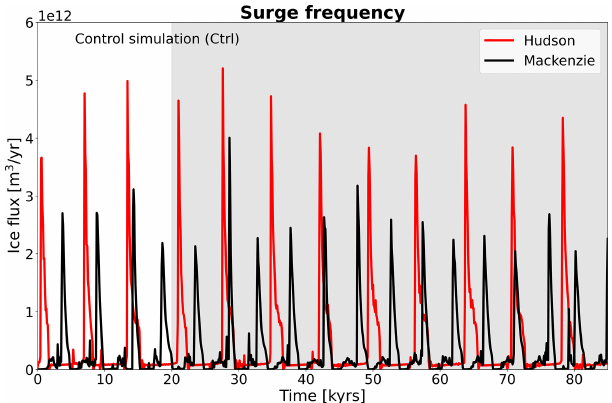
Figure 3. Time series of the ice flux through the flux gates pre- sented in Fig. 1. Peak discharges define ice-sheet surge events. Grey shading highlights the analysis